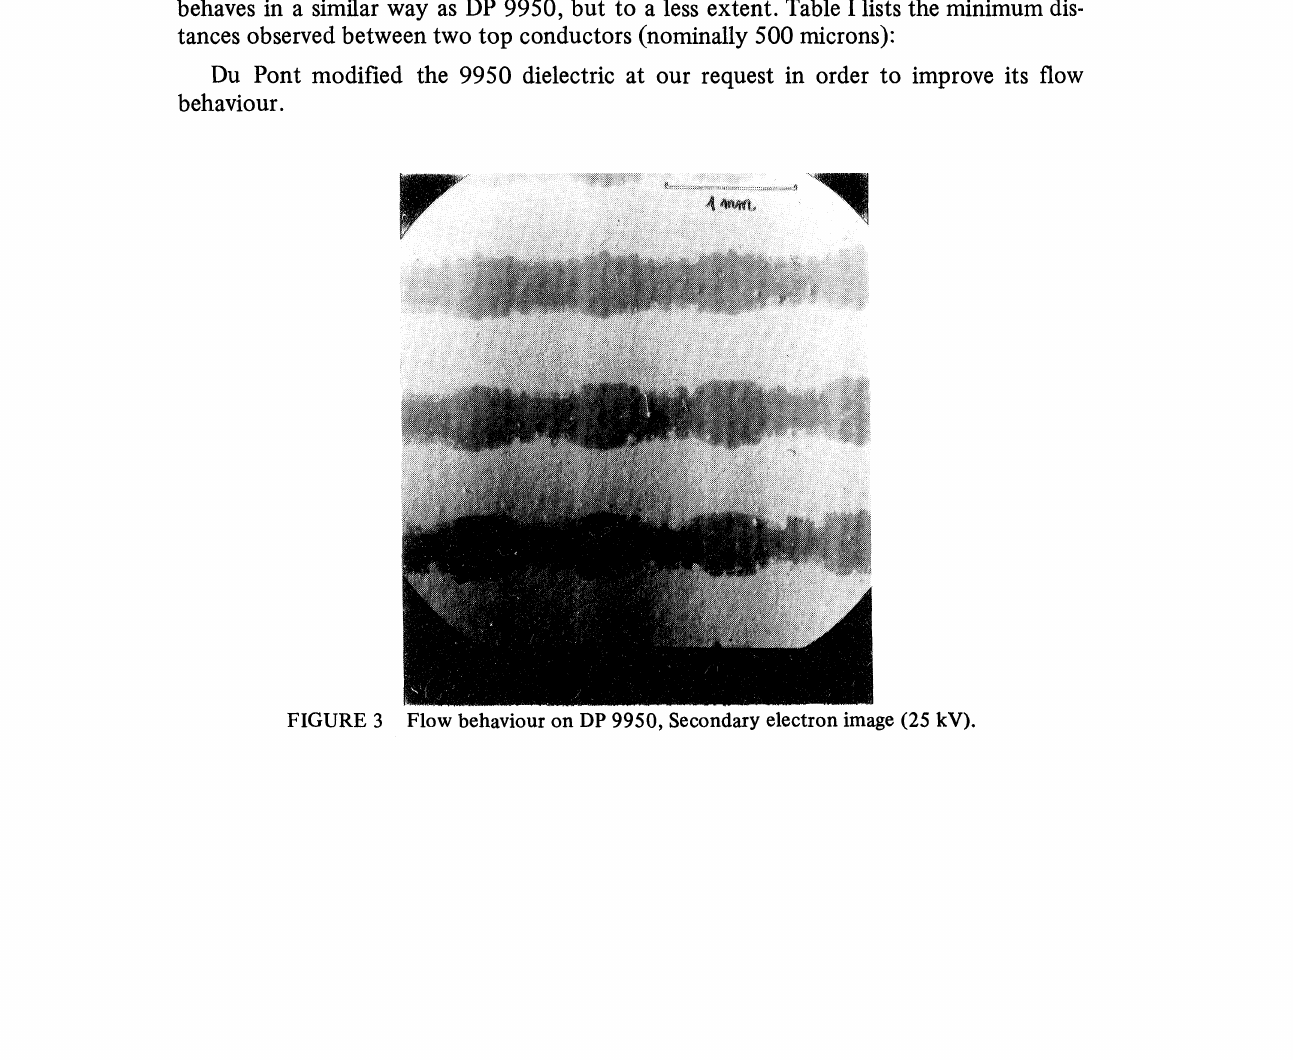
FIGURE 2 Surface aspect of DP 9429, Secondary electron image (25 kV).